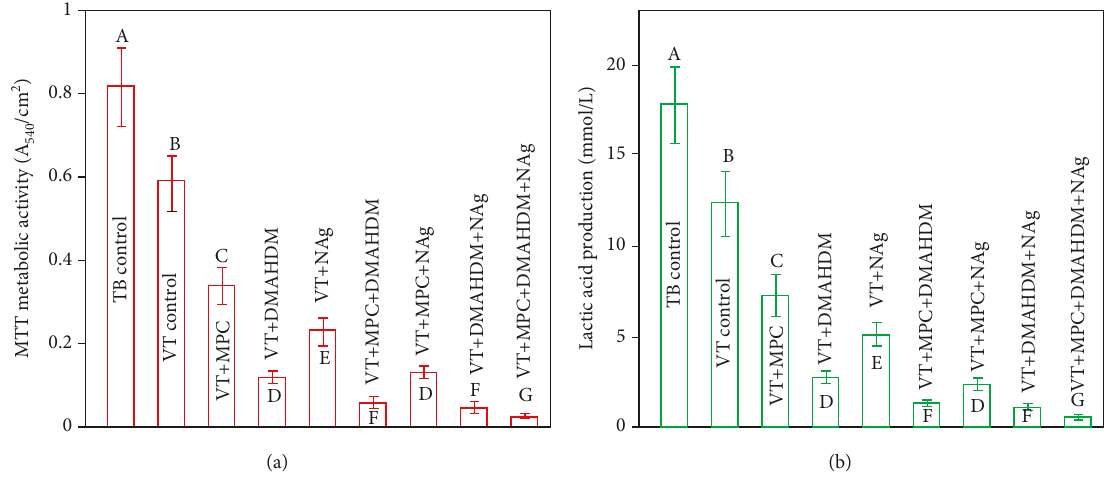
Figure 2: Quantitative viability of the 2-day bio fi lms on disks: (a) metabolic activity and (b) lactic acid production ( mean ± sd ; n = 6 ). Bio fi lms on the VT containing 3% MPC+1.5% DMAHDM+0.1% NAg had the least metabolic activity and lactic acid production among all groups. In each plot, values with dissimilar letters are signi fi cantly di ff erent from each other ( p < 0 05 ). (Adapted from reference [38], with